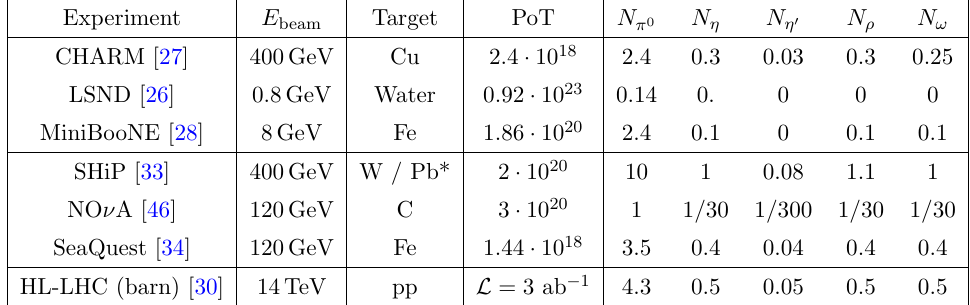
Table 3 . Beam and target characteristics for various experiments, along with the total number of protons on target (PoT) and the average number of a given meson per proton. E beam is the beam kinetic energy. The SHiP design is not (cid:12)nal. References point either to an analysis paper in the case of existing constraints, or to prospective bounds in the case of future experiments. The ratios quoted for NO (cid:23) A account only for primary mesons (see [46]). For MiniBooNE, we use the ratios and normalisation from the recent o(cid:11)-target analysis